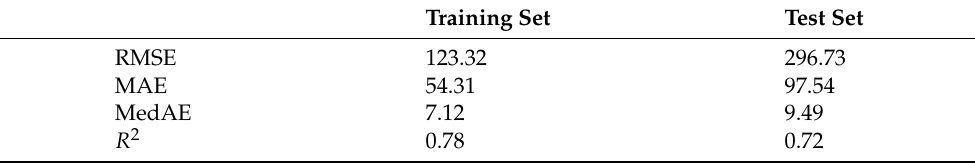
Table 2. Metrics for MLPRegressor model for the execution time of interior point